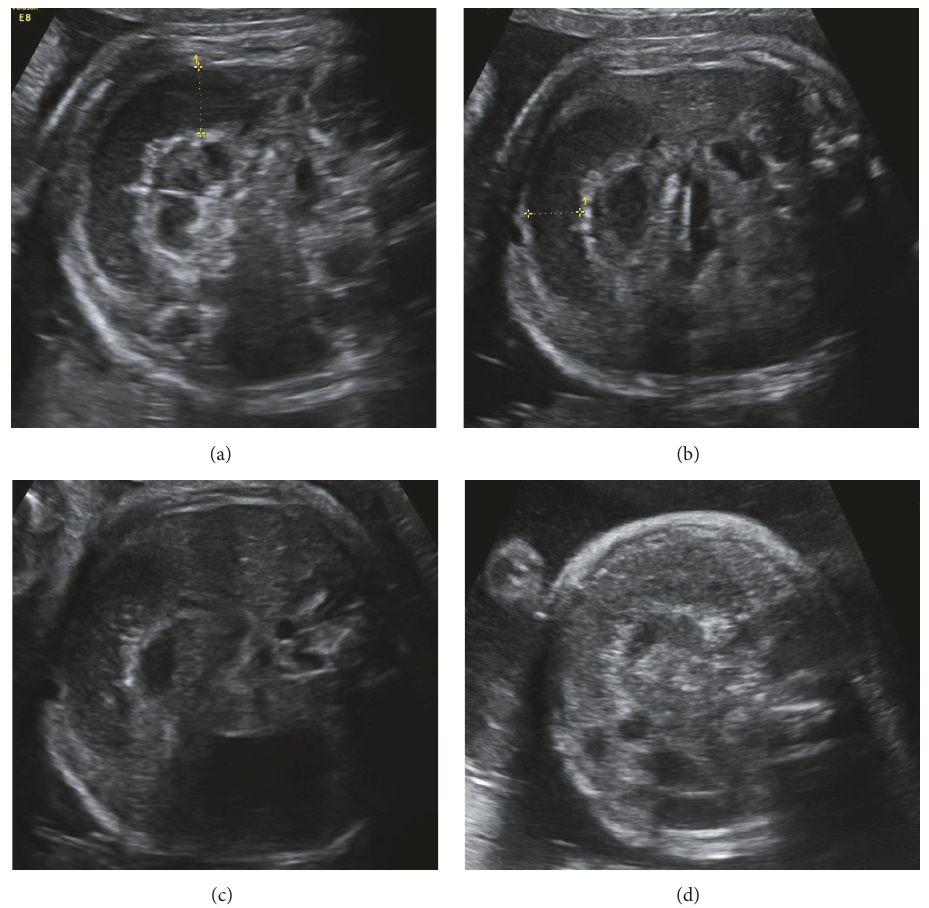
Figure 2: Ultrasound images showing progressive changes within the fetal bowel over time. (a) At 31 +6 weeks, echolucent bowel contents with a diameter of 14mm. (b) At 31 +6 weeks, a loss of clear bowel wall border. (c) At 32 weeks, increasing echogenic particles within the bowel lumen. (d) At 32 +1 weeks, bowel contents appear echogenic.